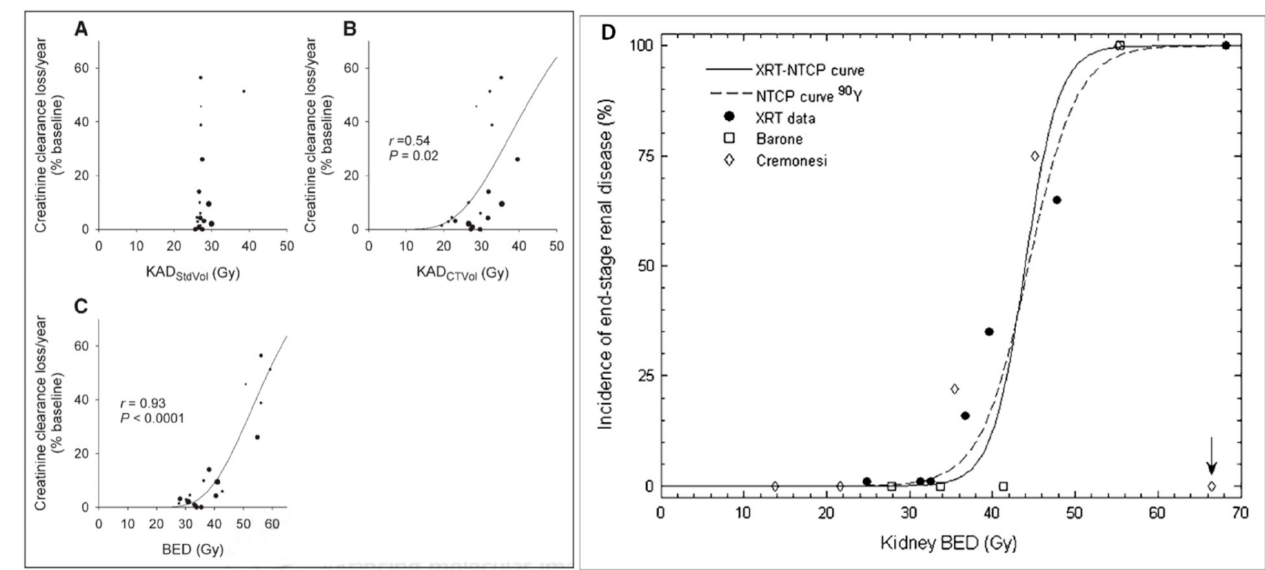
Figure 1. ( A ) Toxicity observed in the 86 Y-SMT-487 phase I trial as a function of the absorbed dose computed with the MIRD pamphlet no. 11 formalism [11], ( B ) after rescaling with the individual kidney volume and ( C ) converted into BED. The dots diameter corresponds to the number of cycles. Reprinted with permission from Ref. [8]. Copyright 2021 SNM. ( D ) Matching of the NTCPs observed in 90 Y-DOTATOC with that of EBRT. Reprinted with permission from Ref. [13]. Copyright 2021